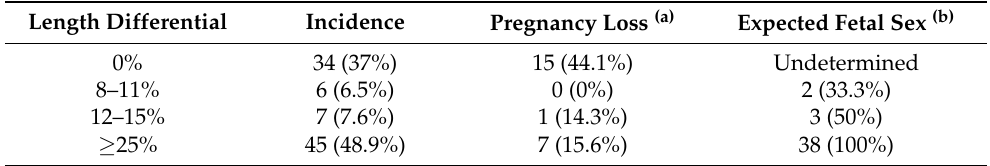
Table 1. Threshold length differentials on day 28–34 of pregnancy, defined as the percentage of difference between co-twins with respect to the larger embryo, used to determine embryo sex ( n = 92 twin embryo